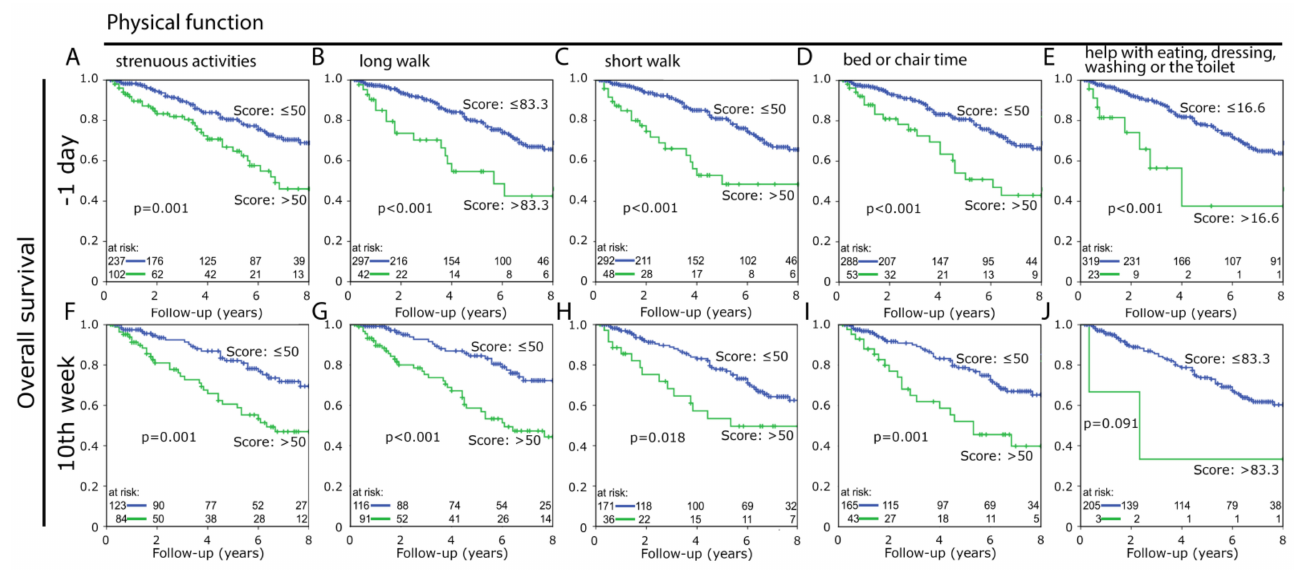
Figure 4. Overall survival between the group with lower (upper blue line) and higher (lower green line) scoring for the five questionnaire items representing “physical function”, with respective cutoff values at day -1 for ( A ) “strenuous activities”, ( B ) “long walk”, ( C ) “short walk”, ( D ) “bed or chair time”, ( E ) “help with eating, dressing, washing or the toilet” and week 10 for ( F ) “strenuous activities”, ( G ) “long walk”, ( H ) “short walk”, ( I ) “bed or chair time”, ( J ) “help with eating, dressing, washing or the